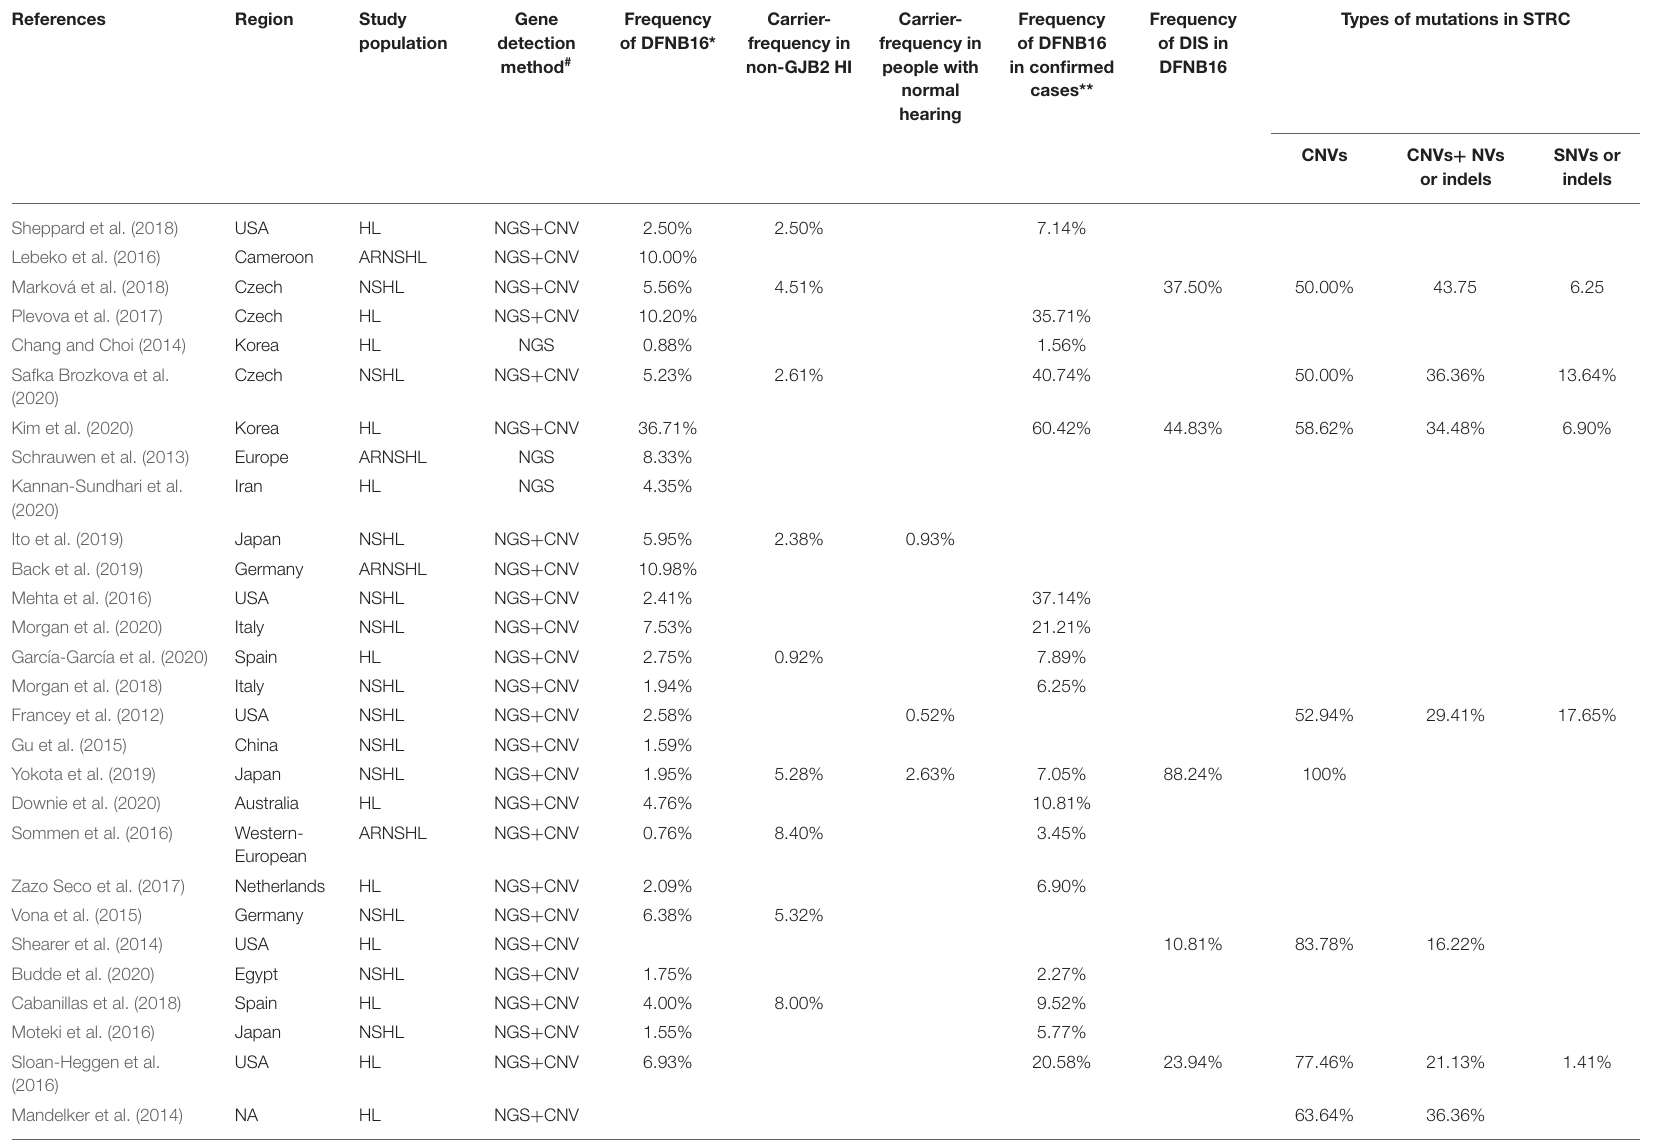
TABLE 1 | Proportions extracted for